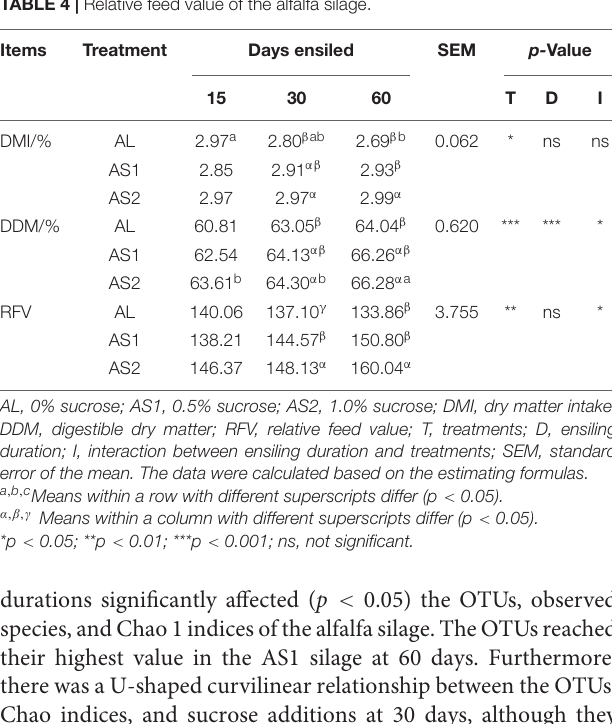
TABLE 4 | Relative feed value of the alfalfa